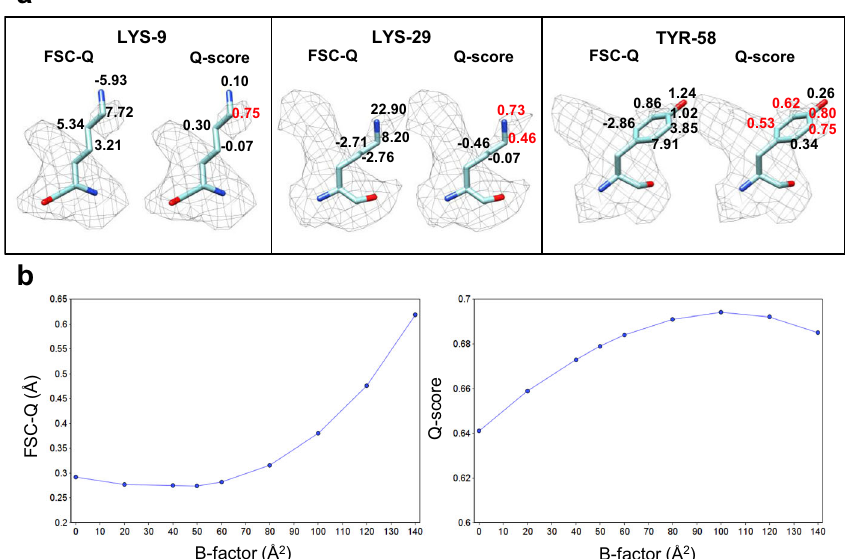
Fig. 3 Comparison between FSC- Q and Q -score. a FSC- Q and Q -scores for each side chain atom for the same residues as in Fig. 1e. b The plots show the effect of B -factor sharpening on average FSC- Q and Q -scores analyzed using the 20 S proteasome